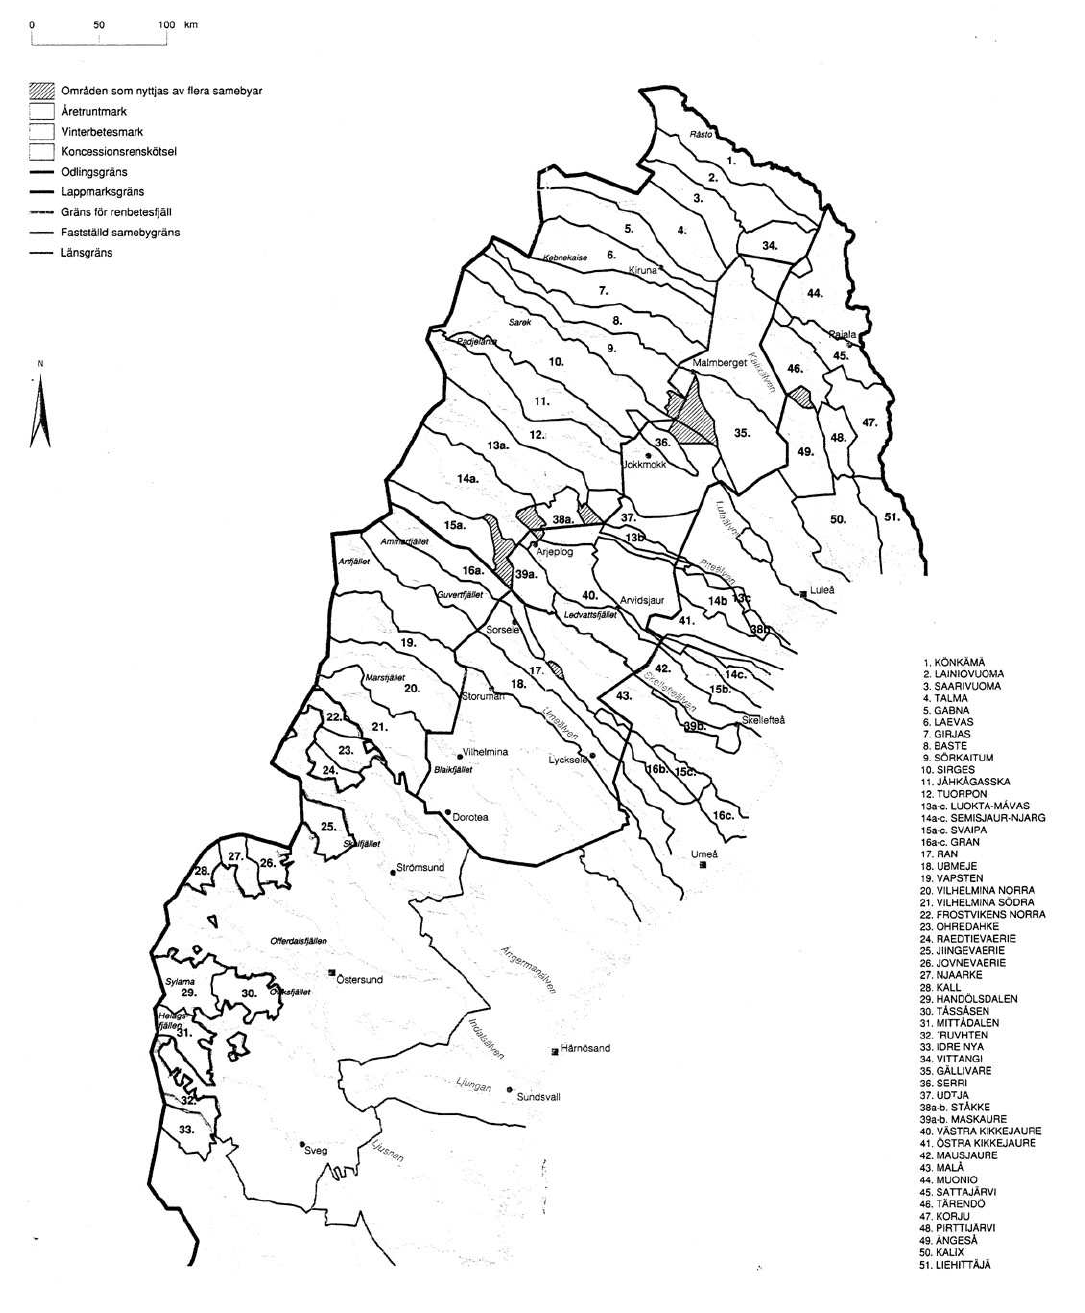
Fig. 4. The present distribution of Sami villages in Sweden. Reindeer is allowed at any time of the year west of the Odlingsgränsen, which is the western of the borderlines stretching horizontally through Lapland. The same goes for the patchwork of reindeer-grazing mountains (Renbetesfjällen) in Jämtland. Between the Odlingsgränsen and the Lapland border (the eastern of the borderlines through northern Lapland) the grazing rights of reindeer is fairly strong between october 1 st and april 30 th (and for the forest-Sami all year round). East of the Lapland border reindeer have a right to graze where they have done so before. That right is vaguely expressed in the law and has been contested in courts lately. In Jämtland reindeer grazing is allowed outside the Renbetesfjällen from October 1 st to April 30 th . In certain areas the Sami have not been able to defend that right in some recent court-cases. In areas 44-51 non-Sami farmers have the right to own a limited number of reindeer (but herded by